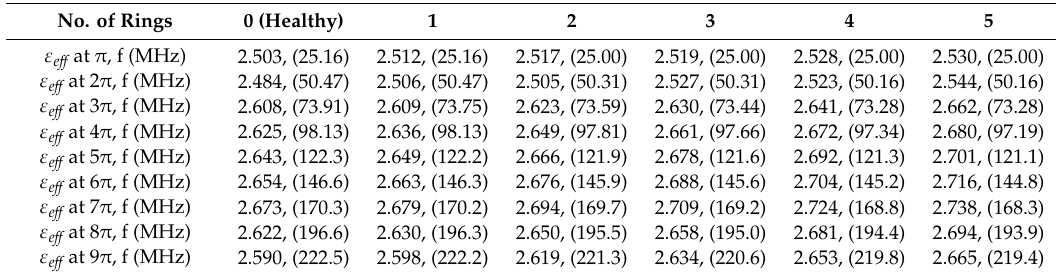
Table 3. Estimated e ff ective permittivity at the multiples of π as the number of rings increases. No. of Rings 0 (Healthy) 1 2 3 4 5 ε e ff at π , f (MHz) 2.503, (25.16) 2.512, (25.16) 2.517,